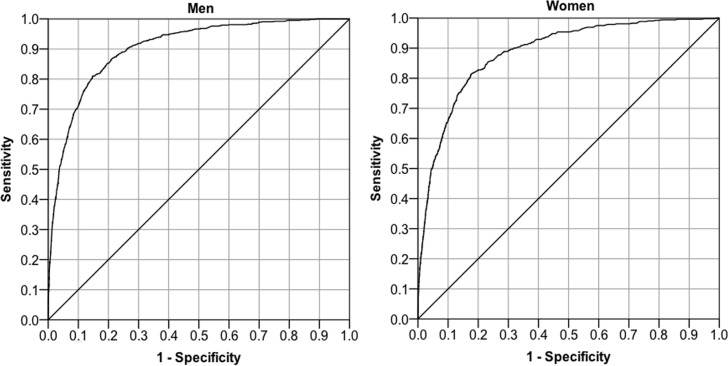
Receiver operating characteristic (ROC) curves of the generalized estimating equation model presented in Table 2.